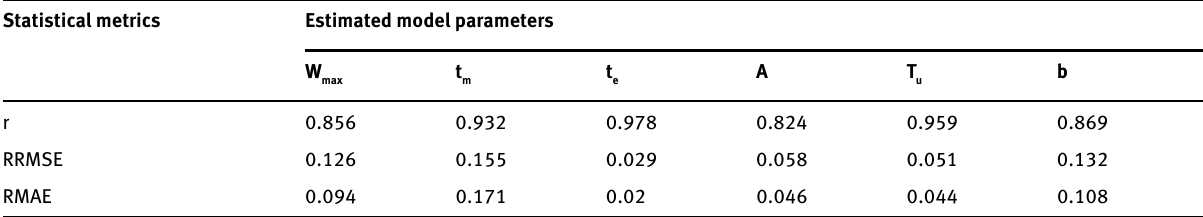
Statistical metrics